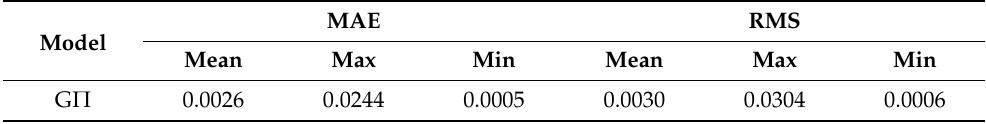
Table 2. Statistical results: external accuracy testing of the G Π